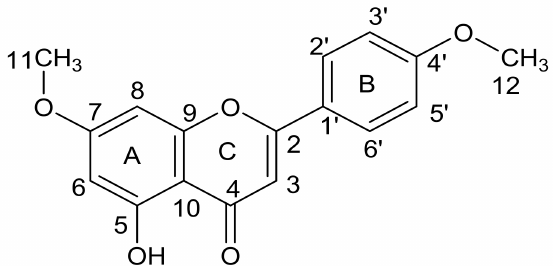
Figure 3. The structure of the flavonoid compound isolated from the C. erythrophyllum leaf acetone